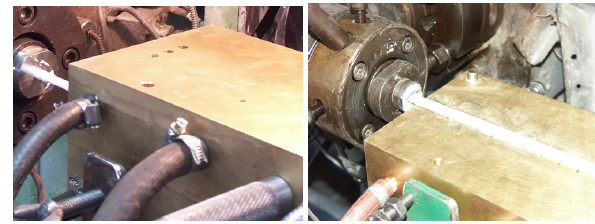
Figure 8: View of vacuum calibrator during operation in the technol- ogy line for cable coat manufacturing.